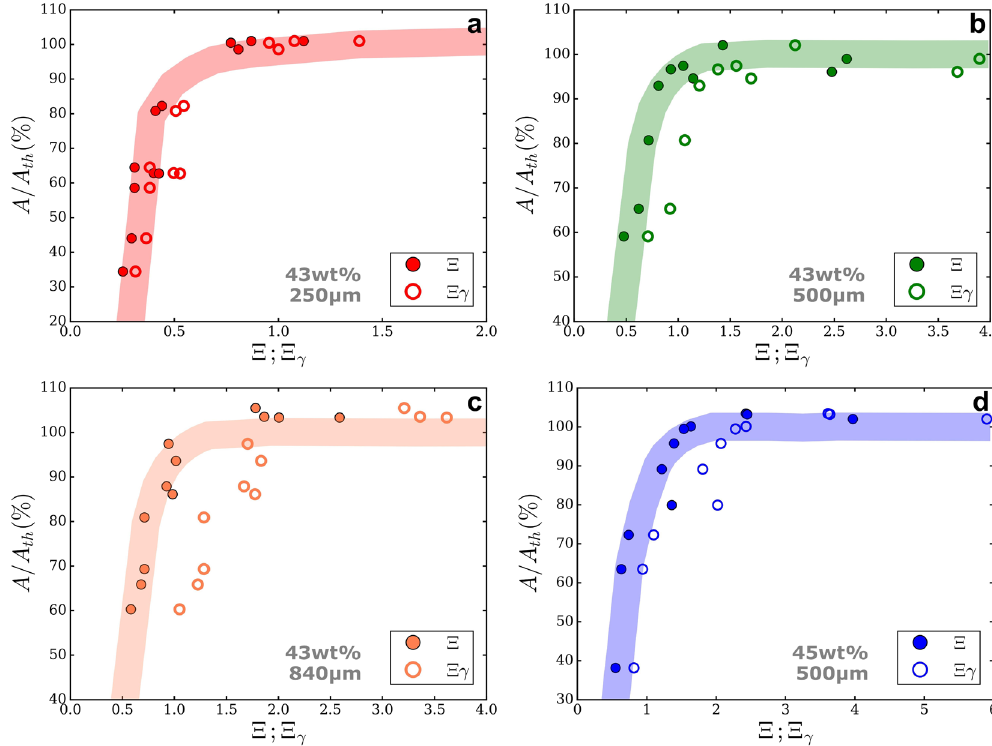
Figure 8. Deformation ratio vs Ξ and Ξ γ for 43 wt% boehmite suspension with ( a ) 250 μ m ( b ) 500 μ m ( c ) 840 μ m nozzle and ( d ) 45 wt% with 500 μ m . Rheological measures for the 43 wt% suspension come from different suspension to ensure an exact correspondance between dynamic yield stress and deformation ratio. Colored stripes were plotted to help see the trend.